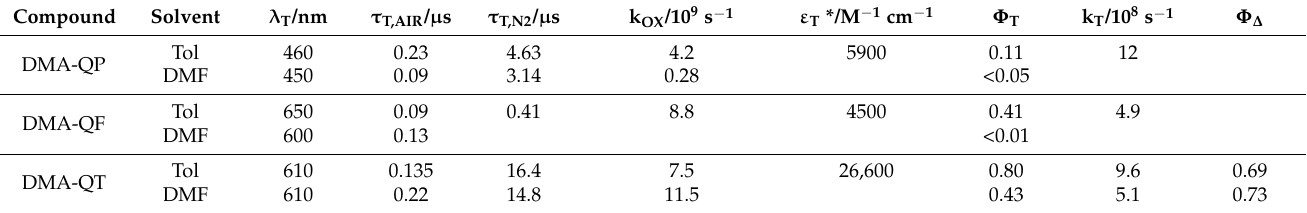
Table 4. Triplet properties of investigated compounds in solvents of different polarity: absorption maximum ( λ T ) and triplet lifetime in the presence ( τ T,AIR ) and absence ( τ T,N2 ) of molecular oxygen with the relative quenching constant (k OX ); molar absorption coefficient ( ε T ) and triplet quantum yield ( Φ T ), kinetic constant (given by k T = Φ T / τ S1 ); singlet oxygen quantum yield ( Φ ∆